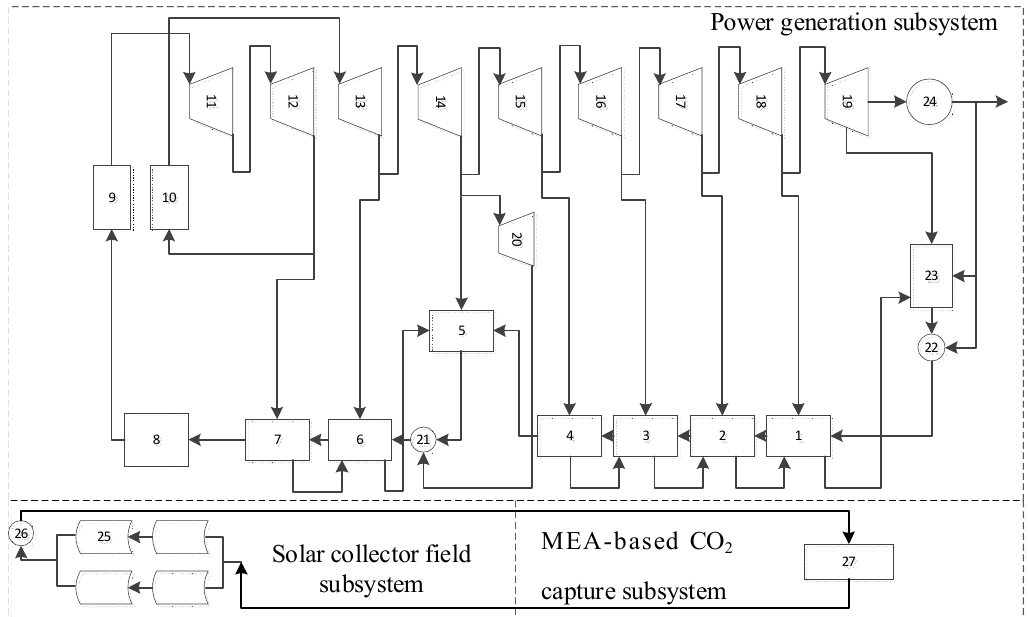
Figure 5. Physical structure of the solar-aided CO 2 capture coal-fired power generation (SA-CC-PG) system.